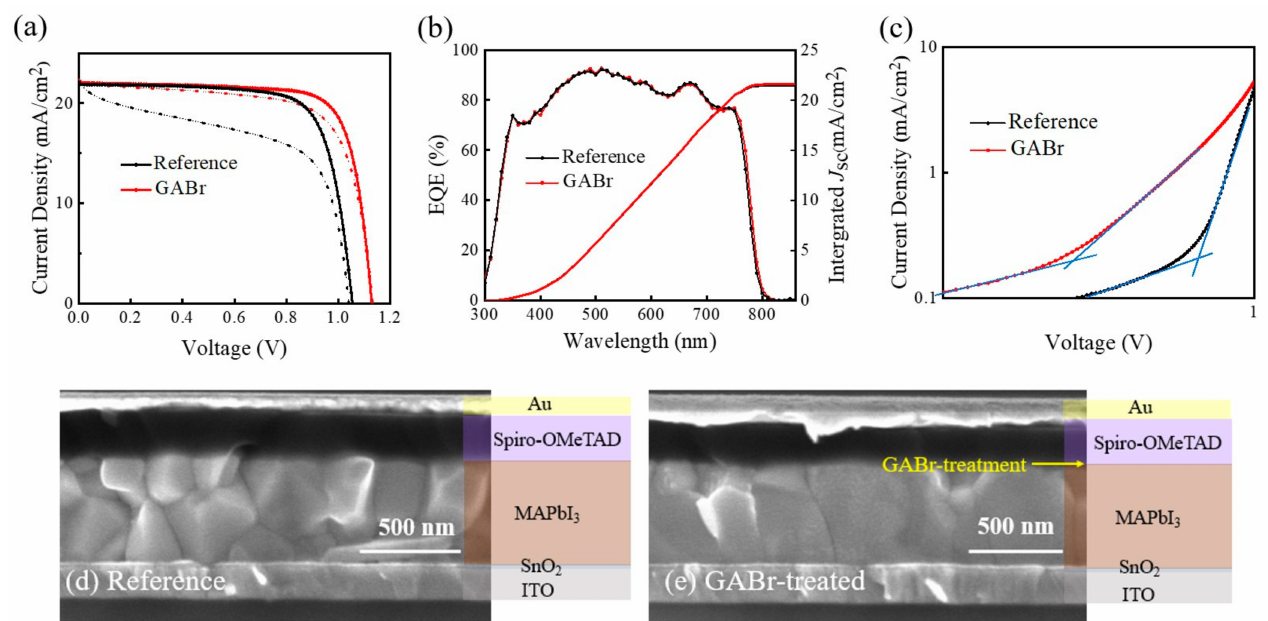
Figure 7. ( a ) The J-V curves, ( b ) external quantum efficiency (EQE) spectra and ( c ) space-charge-limited current (SCLC) results of the champion devices based on MAPbI 3 and GABr-treated device. The cross-sectional SEM images of ( d ) reference devices, and ( e ) GABr-based